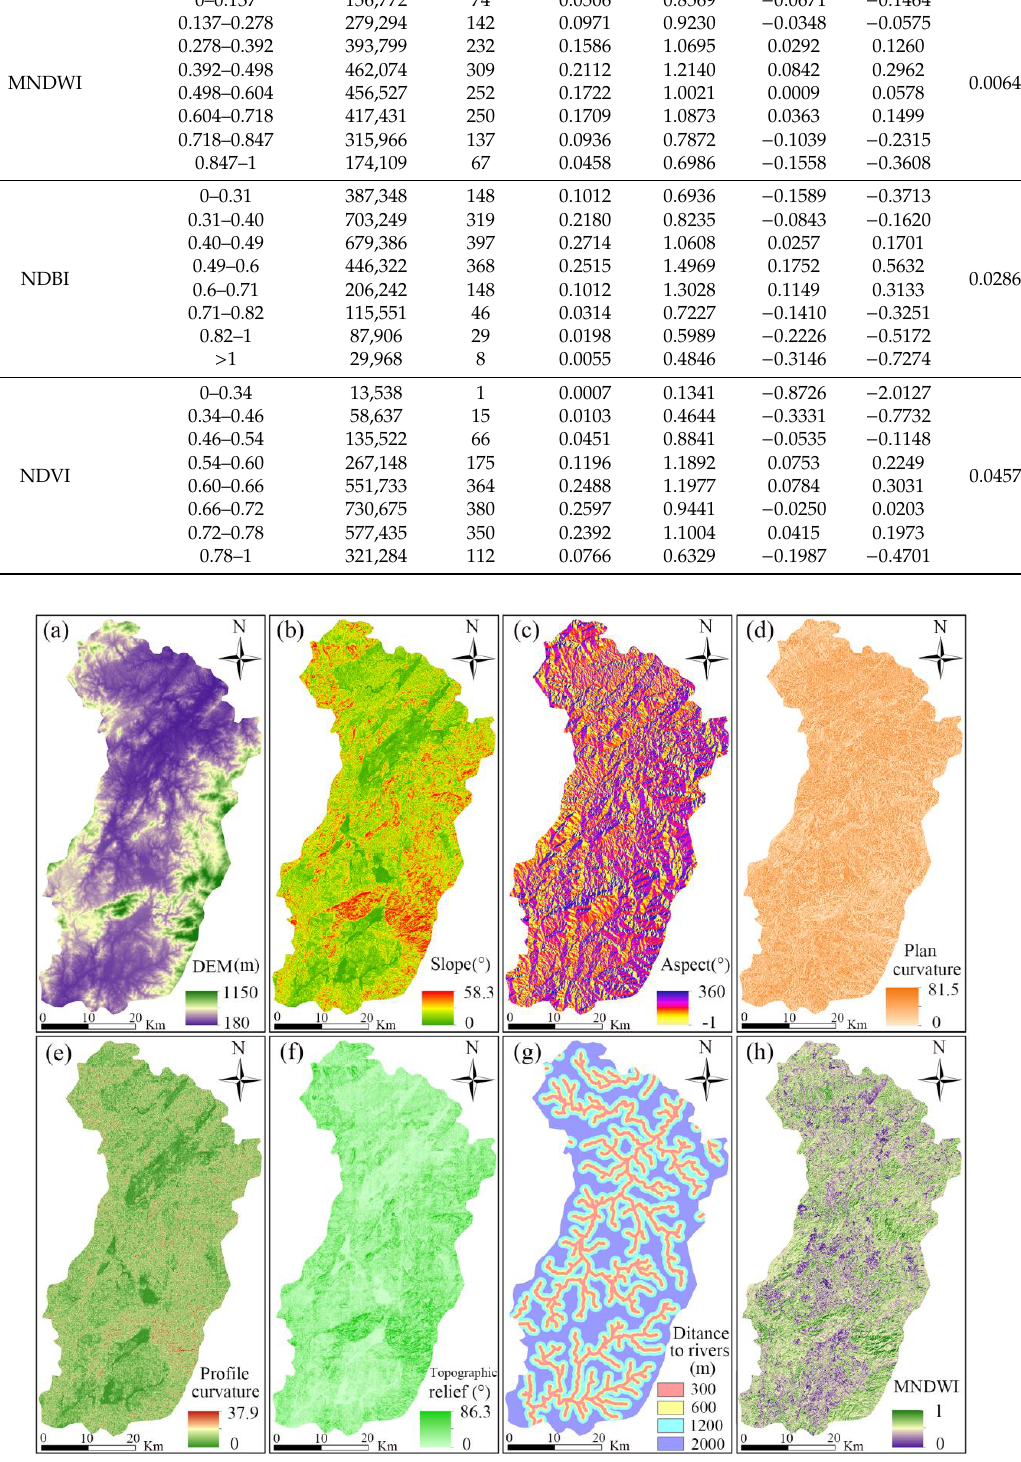
Figure 4. Topographical factors: ( a ) Digital Elevation Model (DEM), ( b ) Slope, ( c ) Aspect, ( d ) Plan curvature, ( e ) Profile curvature, ( f ) Topographic relief, ( g ) Distance to rivers and ( h ) modified normalized di ff erence water index